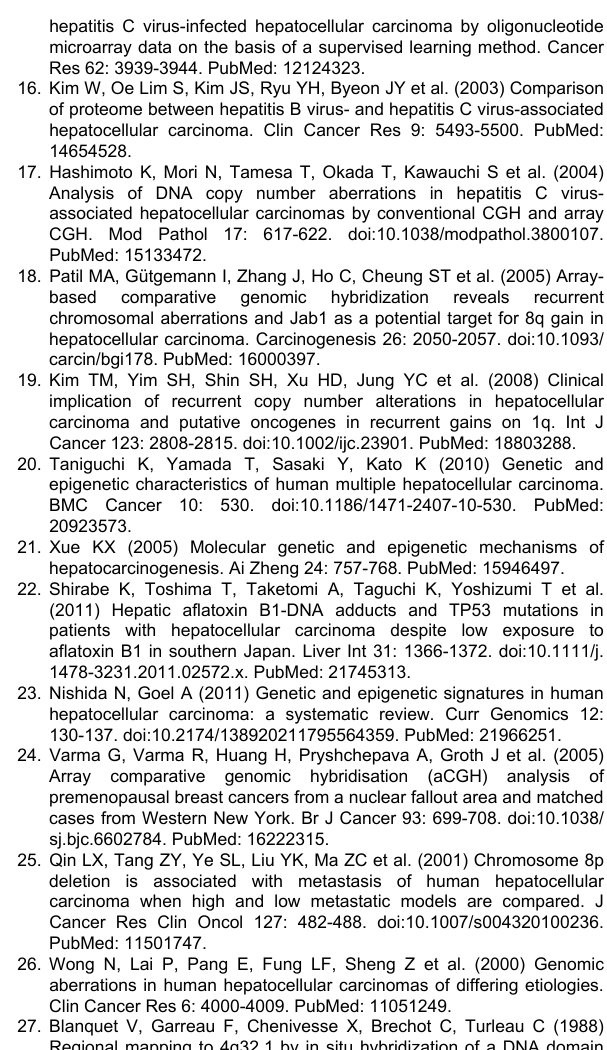
Table S4. Up-regulated and down-regulated proteins whose expression levels differed among 4 patient